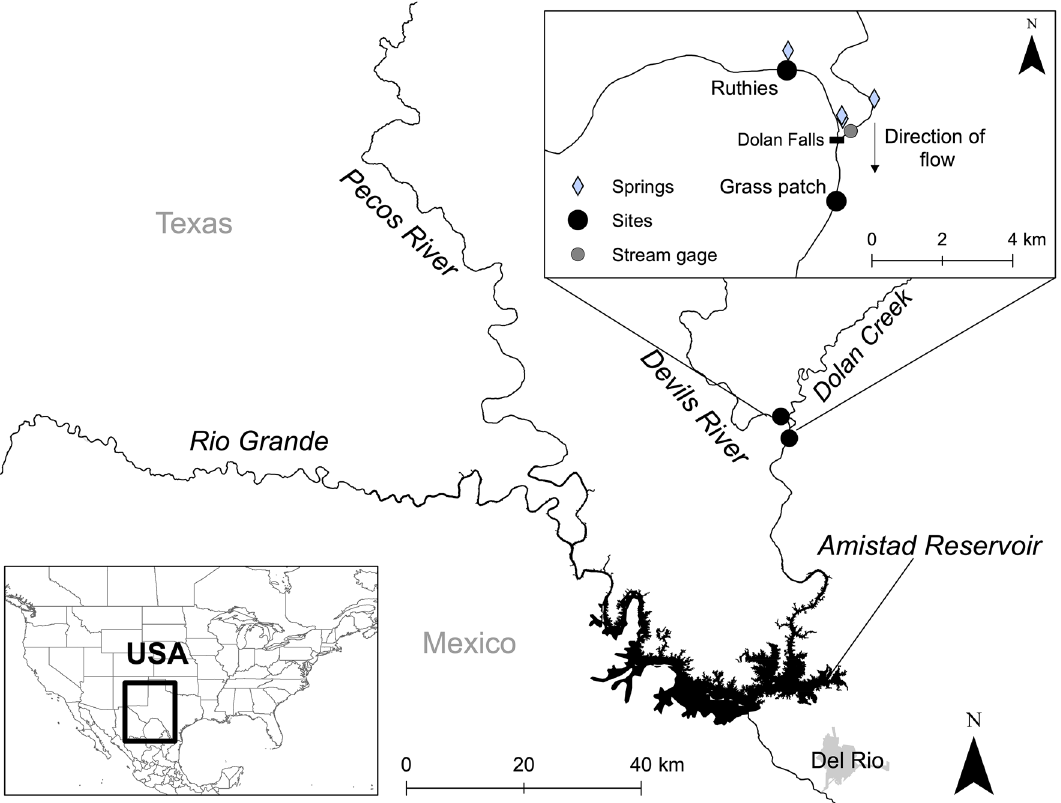
Figure 1. Map of study area. Blue diamonds denote springs, black circles denote sites, and the gray circle denotes the International Boundary and Water Commission (IBWC) gaging station. Gravid females of Popenaias popeii (Texas hornshell) were collected from two sites in the Devils River in Texas. Their glochidia were used in thermal experiments and to produce juveniles for laboratory testing. Figure created using ArcMap 10.8.1 (https:// www. esri. com/ en- us/ arcgis/ produ cts/ arcgis- deskt op/ overv